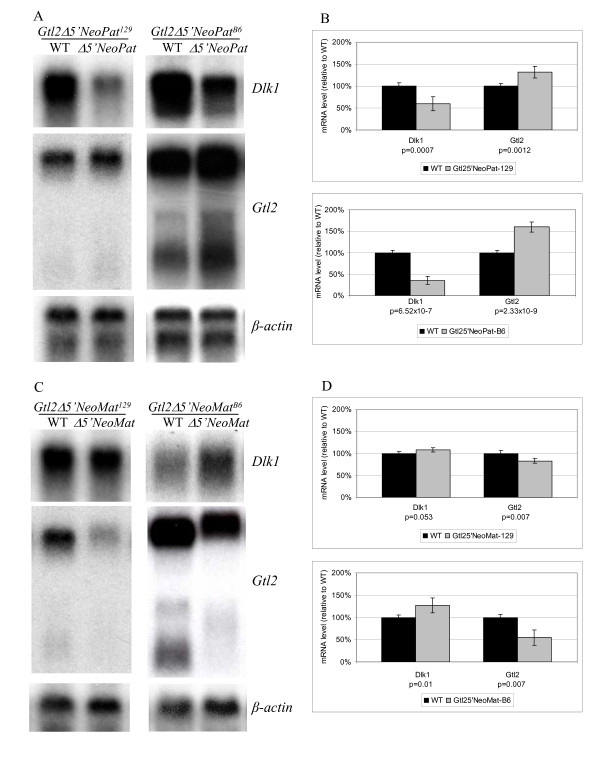
Expression analysis for Dlk1-Gtl2 mRNA in Gtl2Δ5'Neo embryos. A) Representative Northern blots for Dlk1 and Gtl2 RNA levels, in comparison to β-actin, in Gtl2Δ5'NeoPat129 (left) and Gtl2Δ5'NeoPatB6 (right) embryos. B) Graphical representation of quantitative expression data for Gtl2Δ5'NeoPat129 (top) and Gtl2Δ5'NeoPatB6 (bottom) embryos. In each graph, the black bars represent wild type (the mean of these values was set to 100), and the gray bars represent Gtl2Δ5'NeoPat. P-values are indicated below each graph. (Top graph, Dlk1, WT, n = 4, Gtl2Δ5'NeoPat129, n = 6; Gtl2, WT, n = 4, Gtl2Δ5'NeoPat129, n = 6. Bottom graph, Dlk1, WT, n = 6, Gtl2Δ5'NeoPatB6, n = 10; Gtl2, WT, n = 6, Gtl2Δ5'NeoPatB6, n = 10). C) Representative Northern blots for Dlk1 and Gtl2 RNA levels, in comparison to β-actin, in Gtl2Δ5'NeoMat129 (left) and Gtl2Δ5'NeoMatB6 (right) embryos. D) Graphical representation of quantitative expression data for Gtl2Δ5'NeoMat129 (top) and Gtl2Δ5'NeoMatB6 (bottom) embryos. In each graph, the black bars represent wild type (the mean of these values was set to 100), and the gray bars represent Gtl2Δ5'NeoMat. P-values are indicated below each graph. (Top graph, Dlk1, WT, n = 4, Gtl2Δ5'NeoMat129, n = 6; Gtl2, WT, n = 4, Gtl2Δ5'NeoMat129, n = 6. Bottom graph, Dlk1, WT, n = 4, Gtl2Δ5'NeoMatB6, n = 4; Gtl2, WT, n = 4, Gtl2Δ5'NeoMatB6, n = 4).